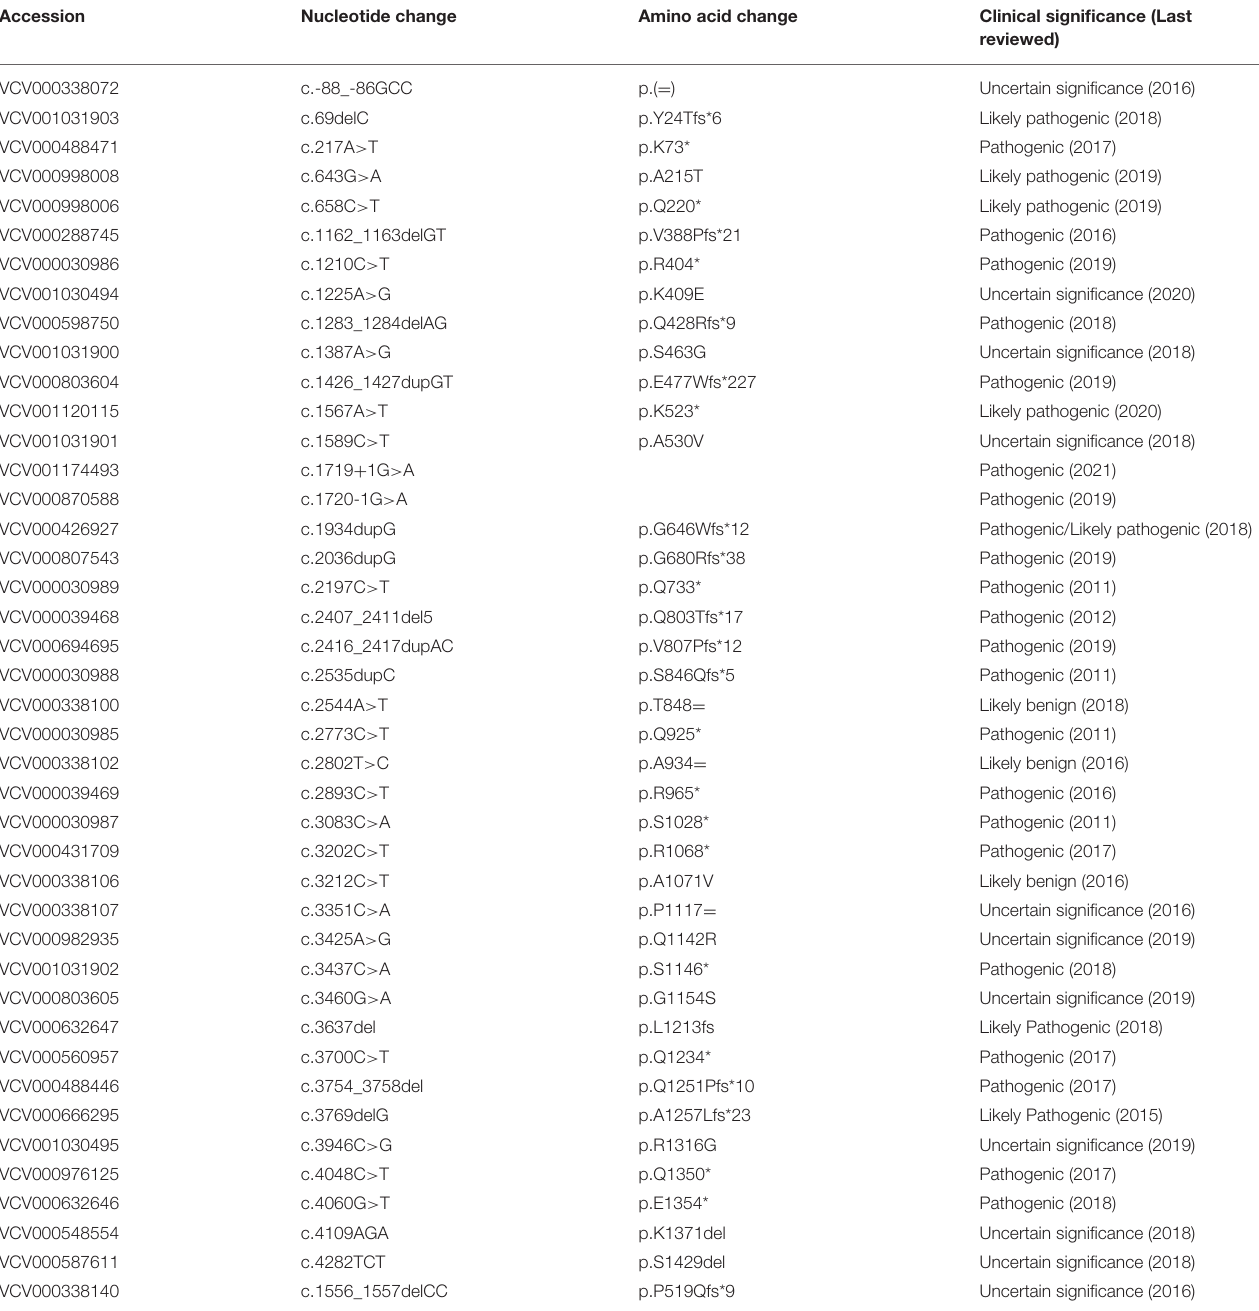
TABLE 3 | ASXL1 gene variants in patients diagnosed with BOS syndrome in the ClinVar